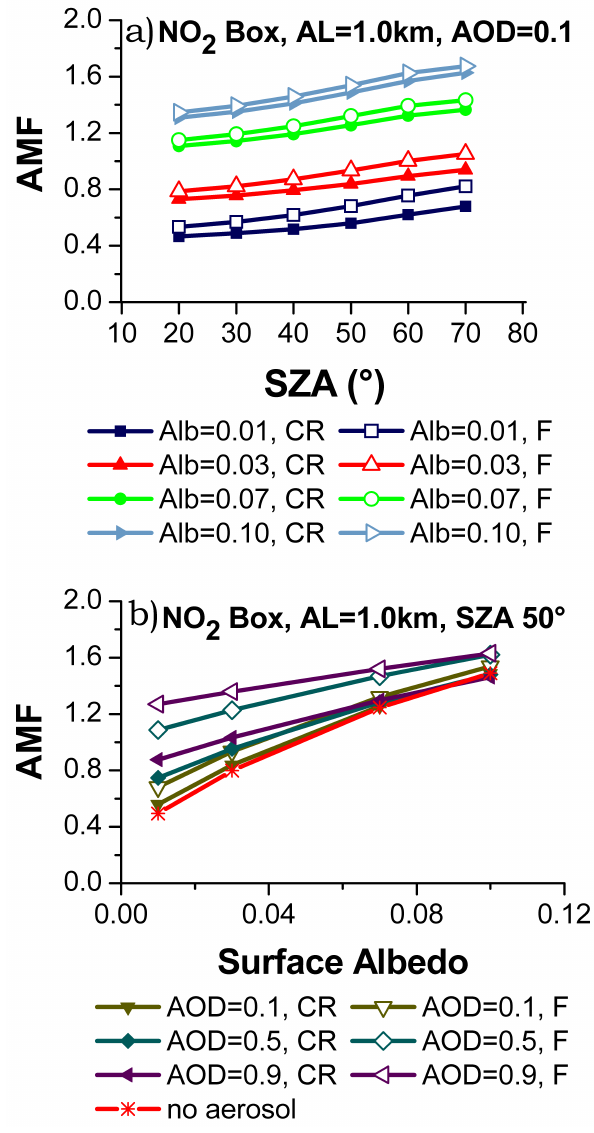
Fig. 5. (a) NO 2 airmass factors for simulations with different sur- face albedo (0.01 (dark blue), 0.03 (red), 0.07 (green) and 0.10 (light blue)). Scenario C (NO 2 and aerosol layer (AL) – 1.0km box profile) was used with the phase functions determined for coarse (CR) and fine (F) particles (optical properties taken from Creteil/Paris AERONET station). AMFs determined at 440nm, with ω 0 = 0.93 and AOD = 0.1. (b) AMF results for same sce- nario as above but for SZA = 50 ◦ and different AODs: 0.1 (green), 0.5 (blue) and 0.9 (purple), and, in addition, for the scenario without aerosol